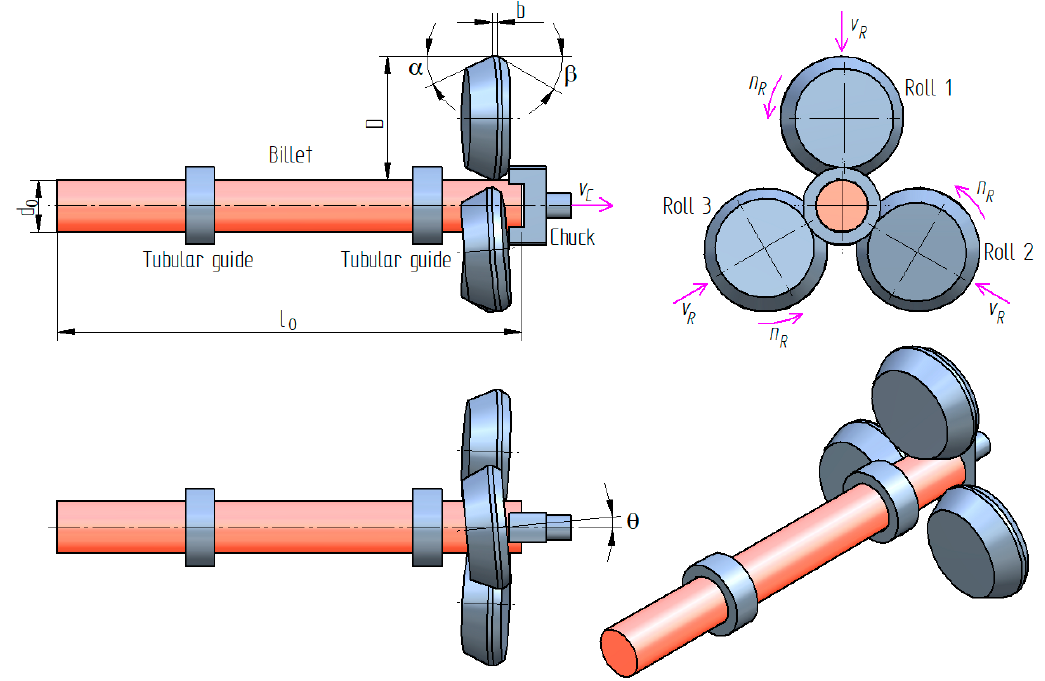
Figure 2. Schematic design of skew rolling in a 3-roll CNC rolling mill.